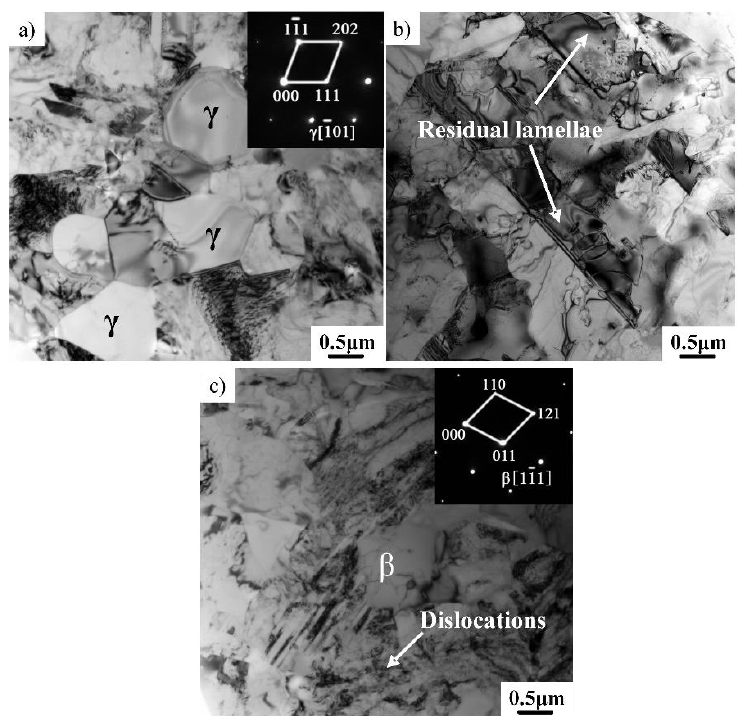
Figure 6. TEM bright field (BF) images of the microstructure corresponding to Figure 5a. ( a ) Equiaxed γ grains, ( b ) residual lamellae, ( c ) β phase.